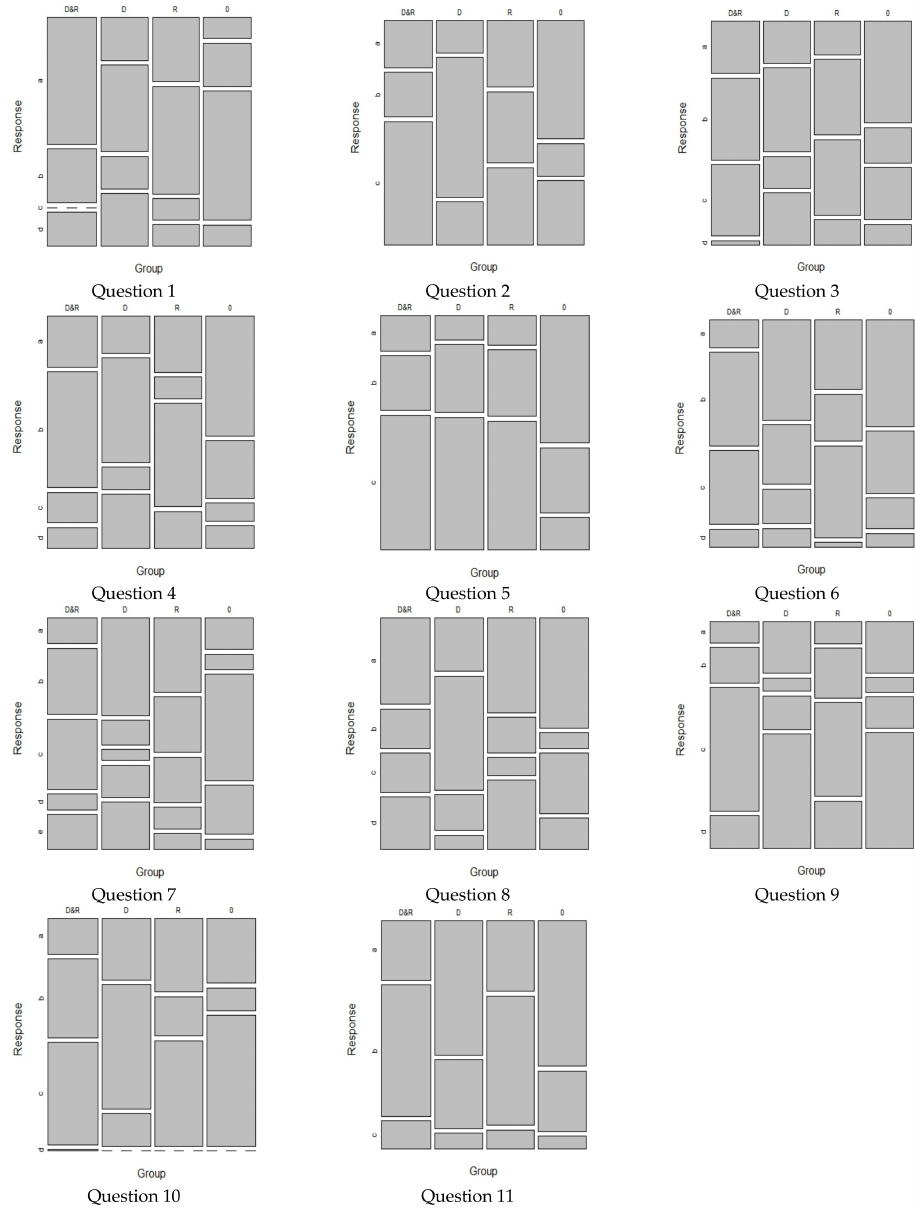
Figure 2. A graphical representation of the observed distributions of questionnaire